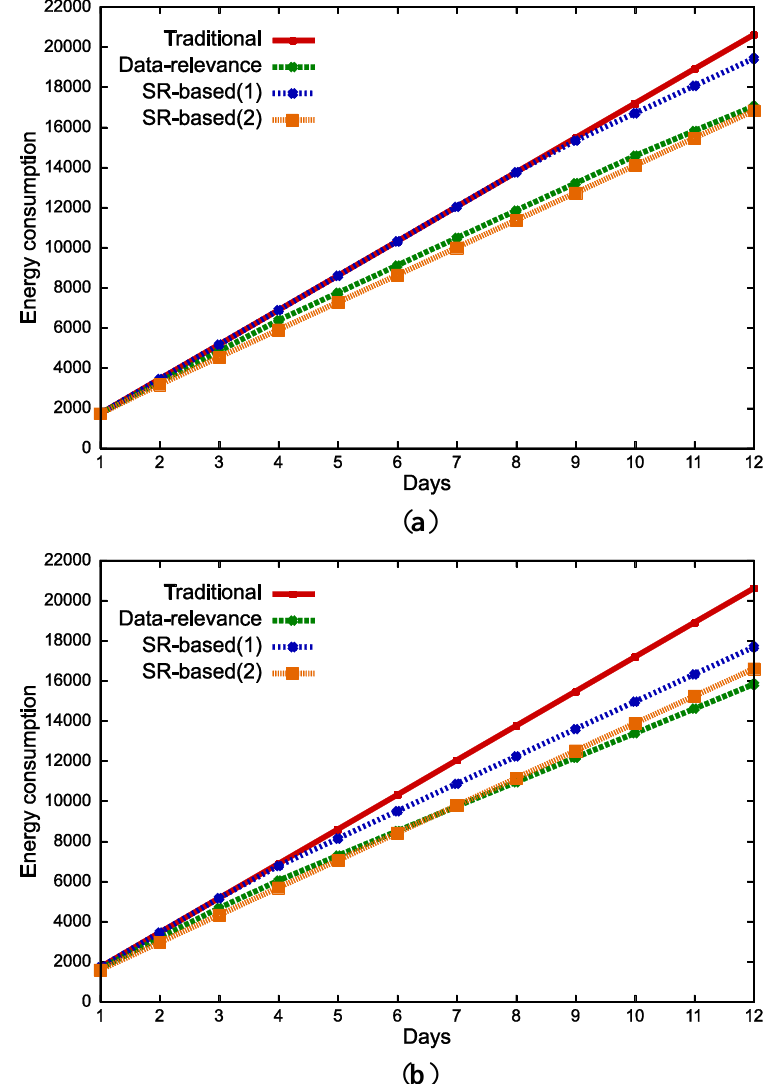
Figure 7. Energy consumption for Scenario 1. ( a ) e e = 0.8 and e 2